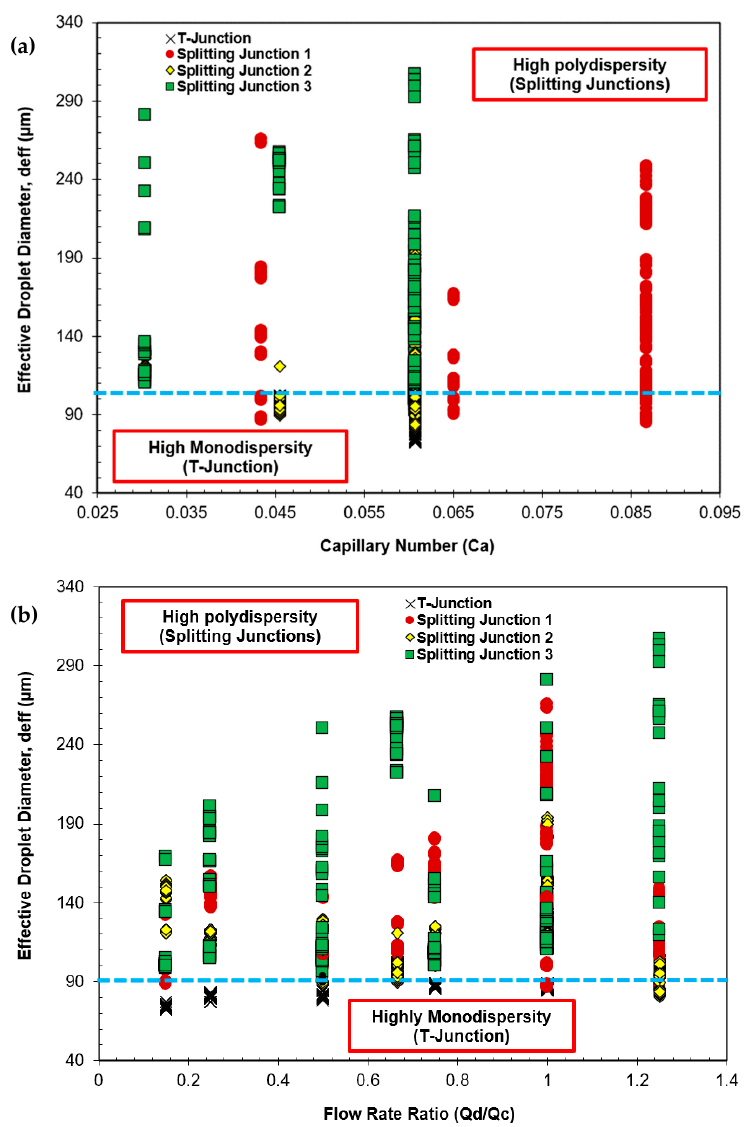
Figure 19. Distribution of droplet size in various regions of interest with respect to: ( a ) Capillary number and ( b ) Flow rate ratio at asymmetrical bifurcating junction.